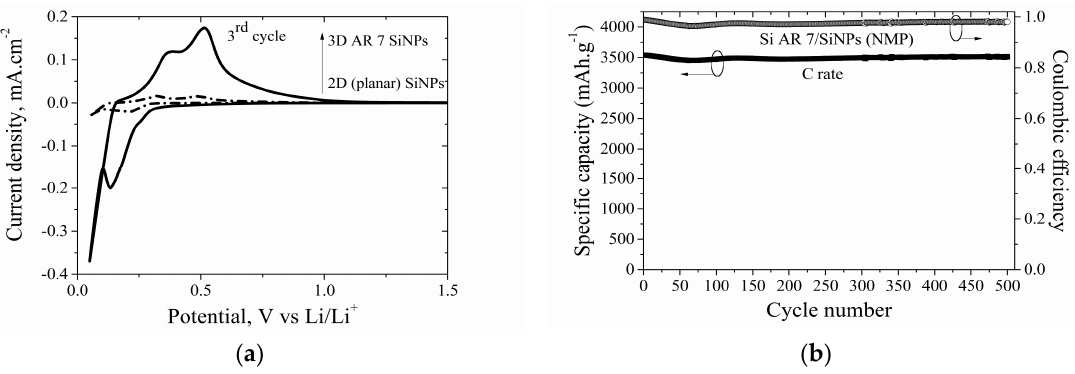
Figure 8. Three-dimensional AR7 SiNPs (NMP) electrode: ( a ) Cyclic voltammograms with 2D SiNPs (NMP) electrode; ( b ) Galvanostatic profile of specific capacities (square plot) and coulombic efficiency (circle plot).